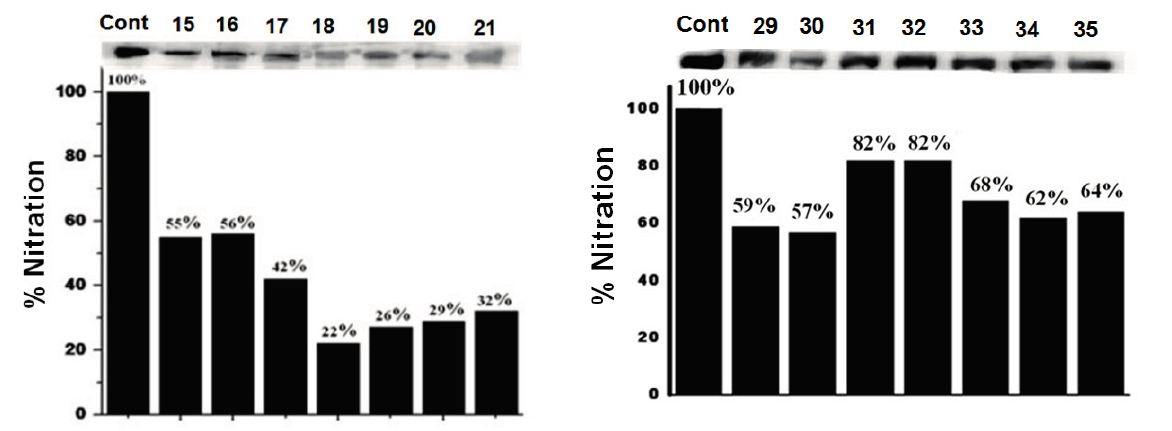
Figure 3. Immunoblots for the inhibition of PN mediated nitration of BSA by diaryl selenides 15 – 21 and spirodiazaselenuranes 29 – 35 . BSA (100 mM) was incubated with inhibitor (166